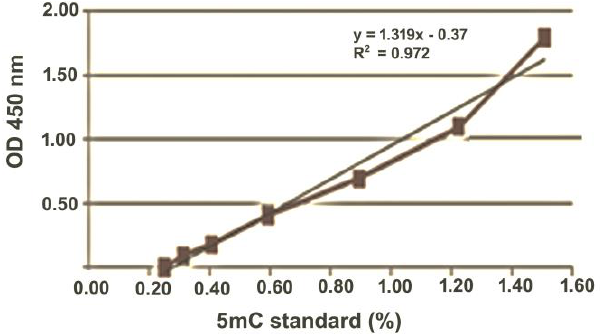
Figure 1. ELISA standard curve. The upper right shows the standard curve equation and the corresponding coefficient of determination. The x axis illustrates the 5mC values of the negative control (0%) and the positive controls (0.1%, 0.2%, 0.5%, 1%, 2% and 5%) expressed as ln (5mC% + 1), whereas the y -axis shows the corresponding absorbances.